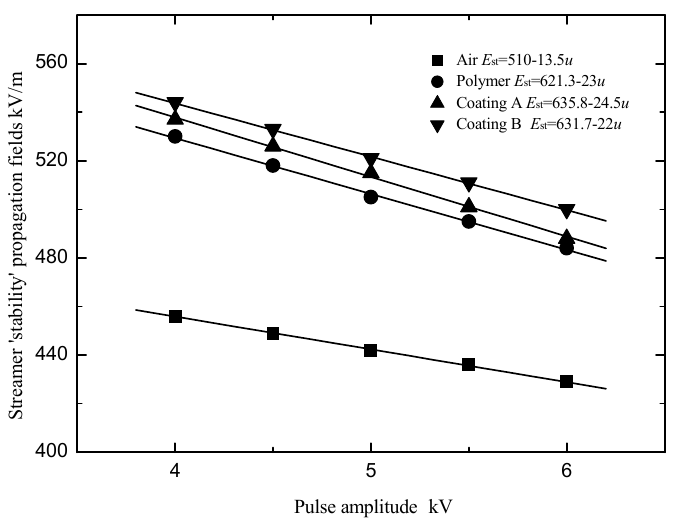
Figure 2. Relationship between the probability of streamer propagation and the guiding electric field.